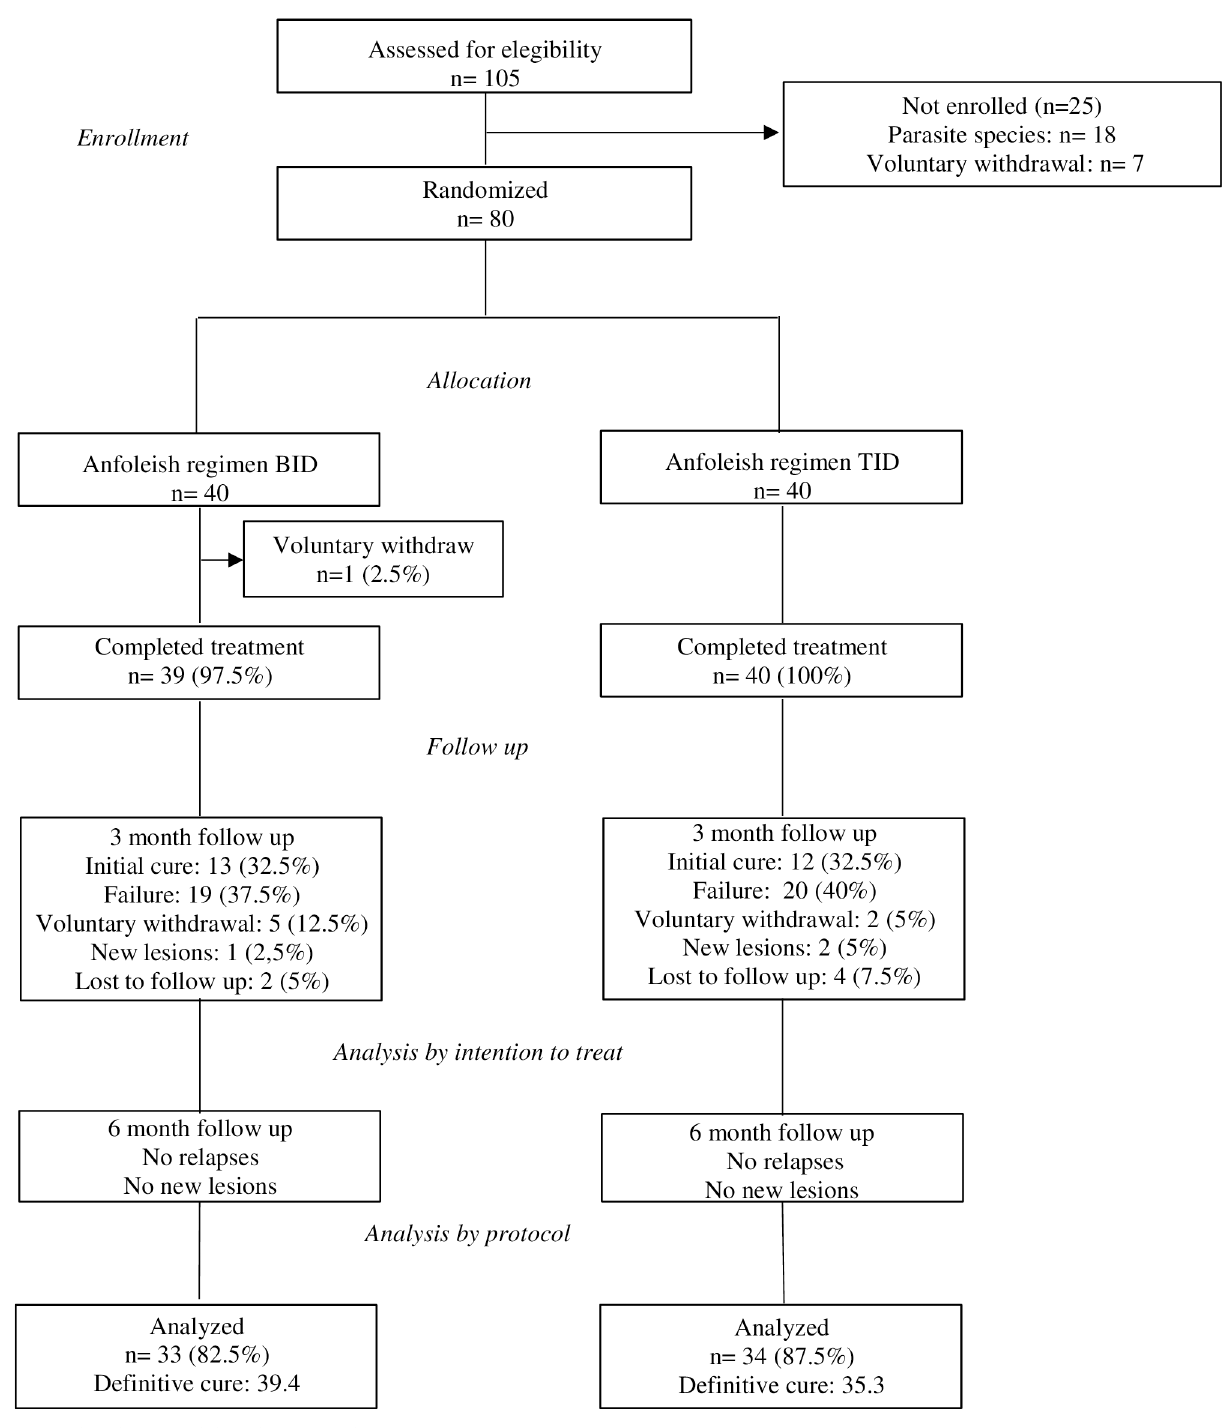
Fig 1. Flow diagram of the volunteer study